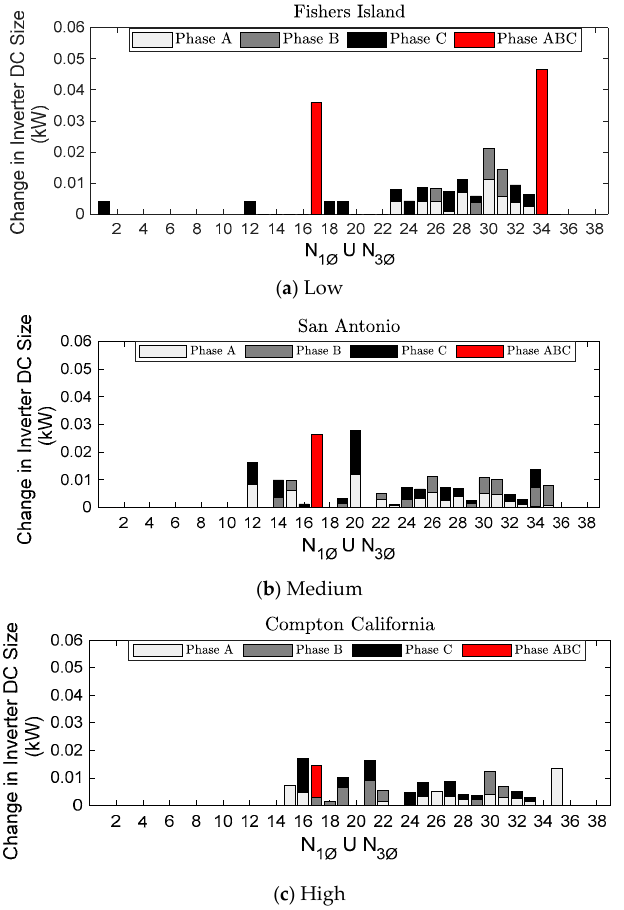
Figure 4. PV inverter placement and size with a load change of +10% in all phases.